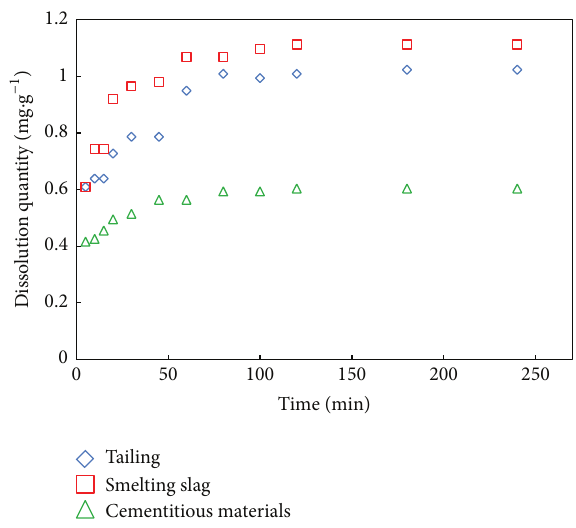
Figure 6: Dissolution quantity of different sample with